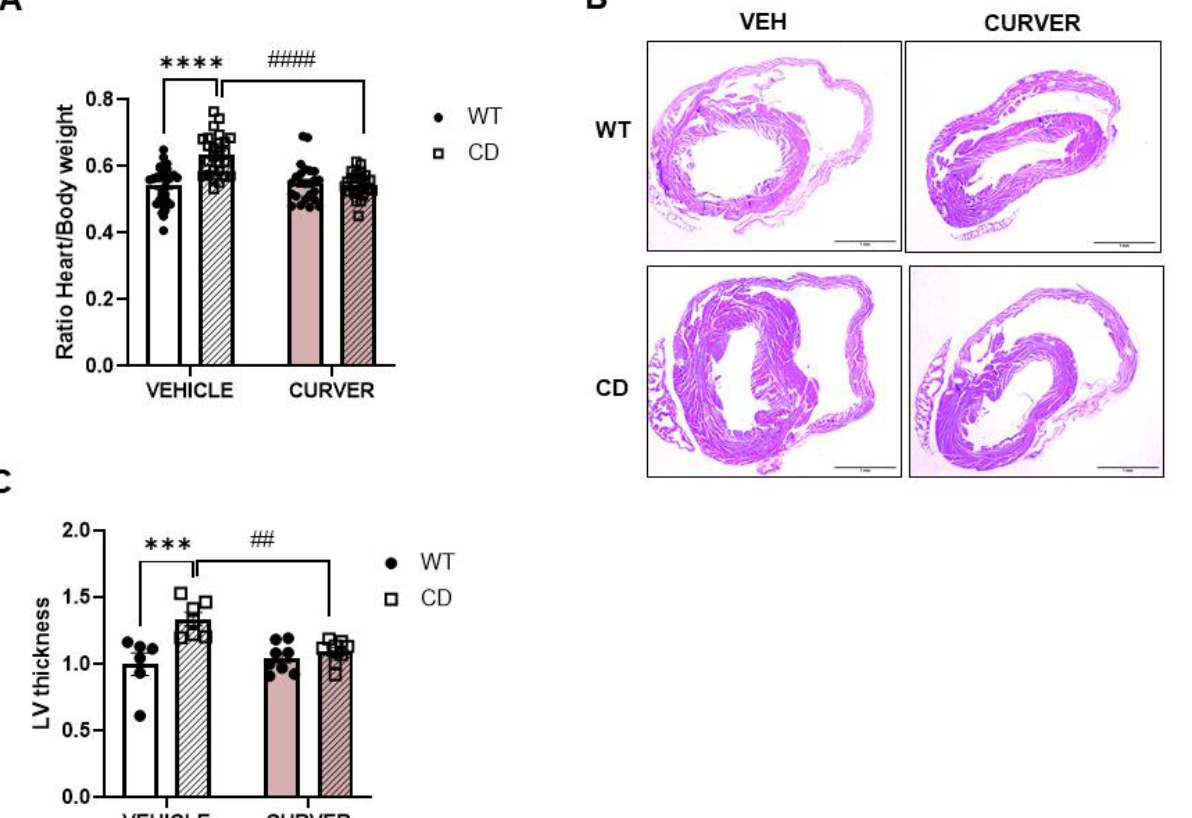
Figure 3. CURVER treatment attenuates cardiac hypertrophy in CD mice. ( A ) Cardiac